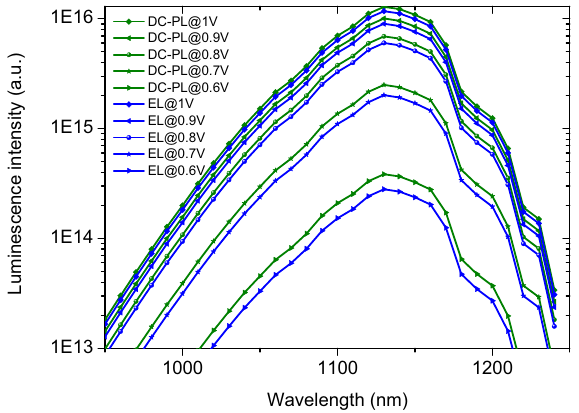
Fig. 3. Model-generated EL and PL under DC-bias